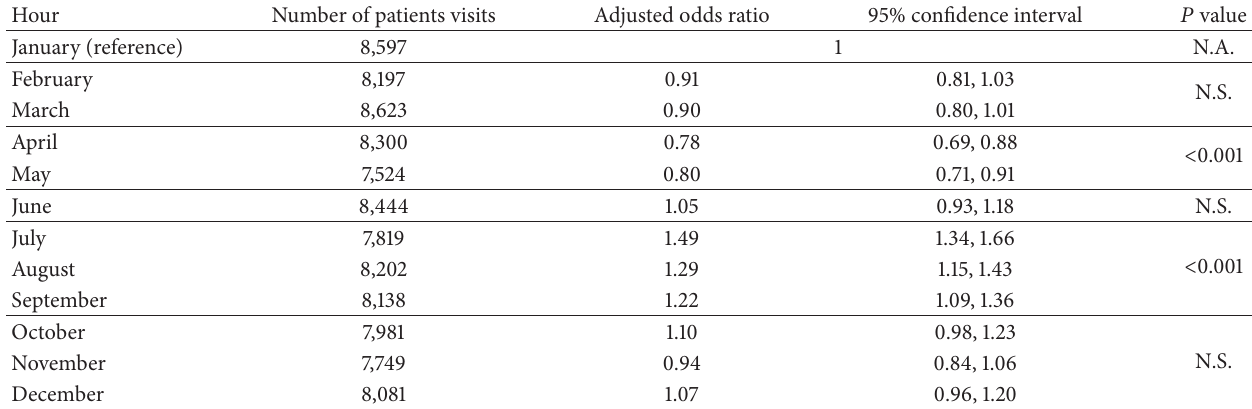
Table 3: Impact of month of patient admission to the ED on the odds ratios of HIV testing.